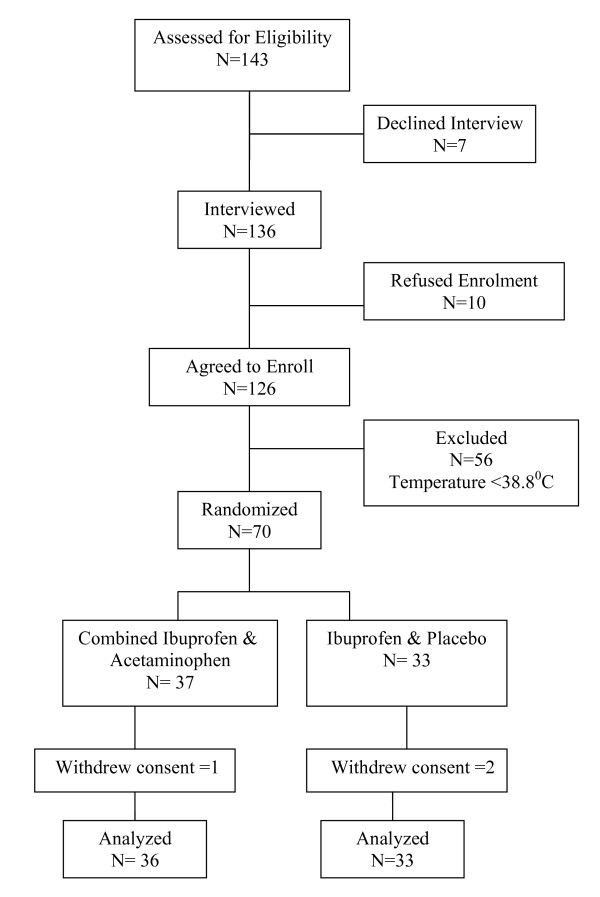
Flow diagram of the subjects' progress through the study.